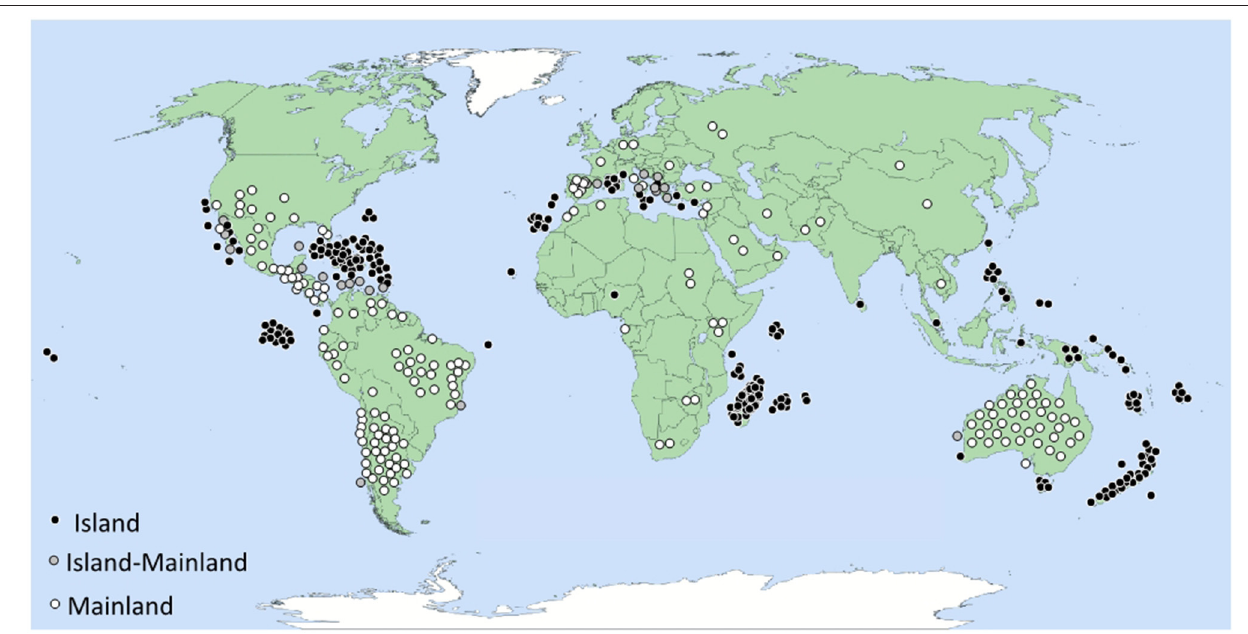
FIGURE 1 | Geographic distribution of 470 fruit-eating lizard species sorted as island-only species ( I ), mainland-only species ( M ) and species present on both island and mainland ( IM ). See also Table S1 in Supplementary Material for a full list of frugivorous lizard species. The map shows not just the distribution of lizard frugivory, but also the heterogeneous sampling efforts. Note, for example, the absence of dots in Japan and Indonesia, which most likely is caused by insufficient field